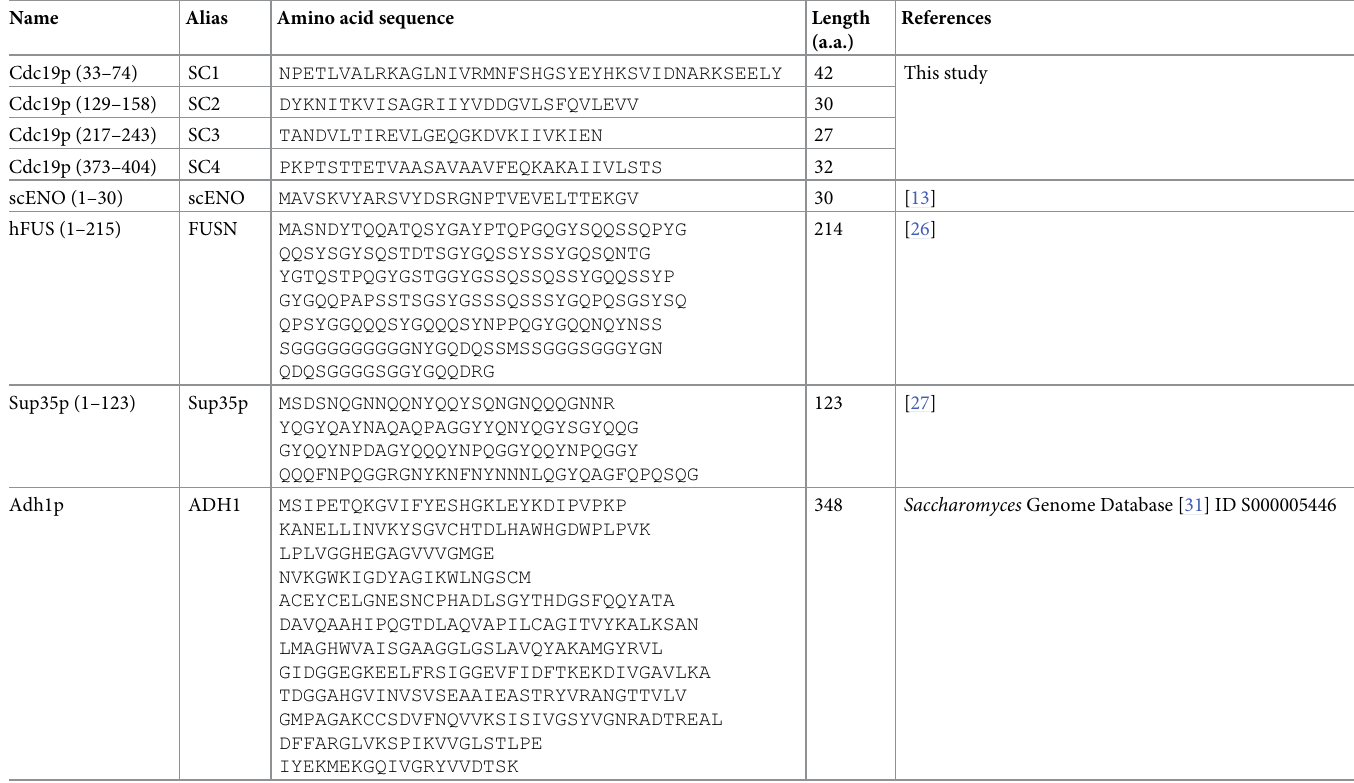
Table 2. Amino acid sequences of peptides and proteins used in the present